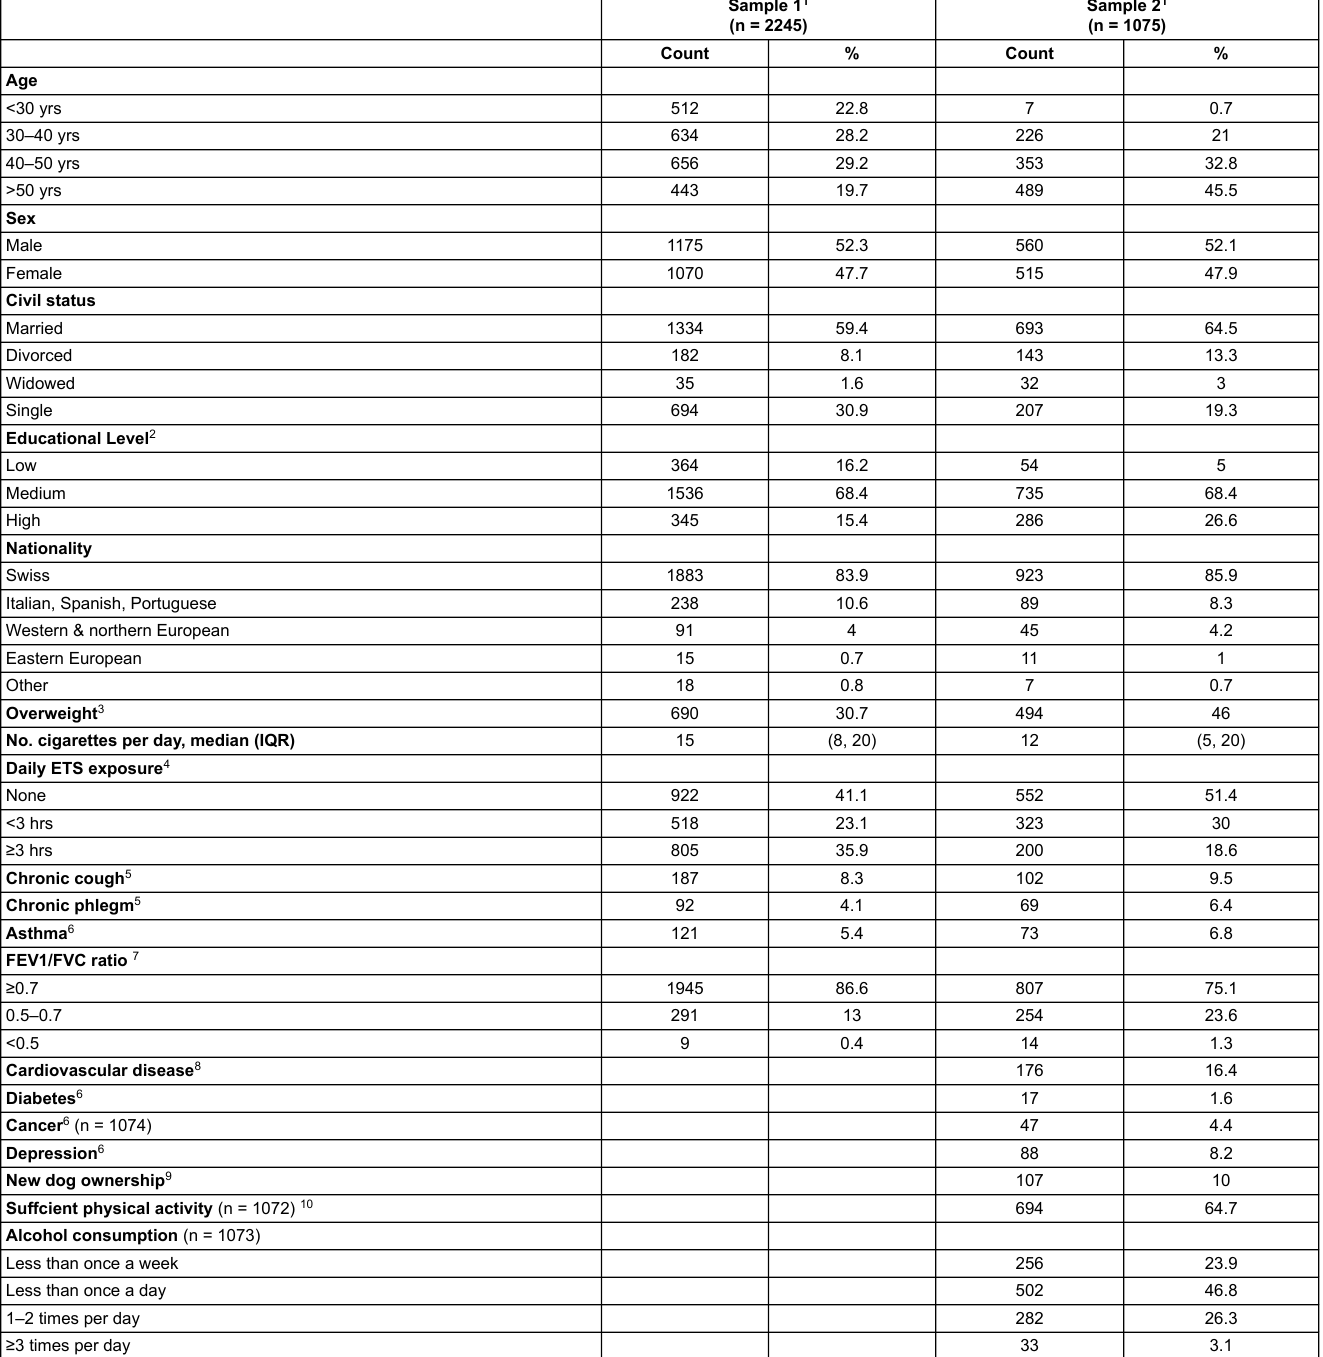
Table S1: Description of the samples included in the analyses of smoking